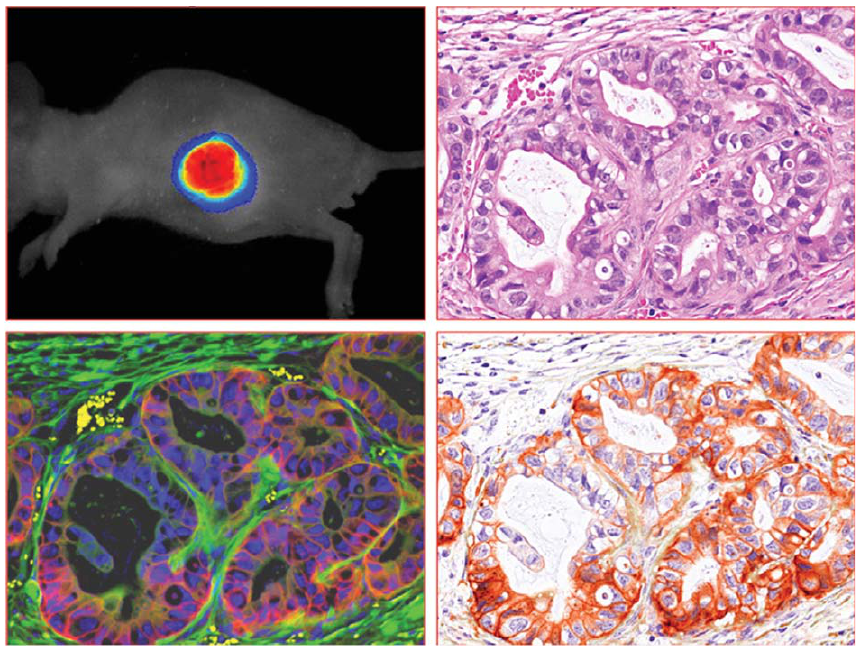
Fig. 10. Spectral imaging of fluorescent in-vivo molecular staining for HER2, H&E staining of FFPE tumor tissue, multispectral imaging, and color-space remapping.